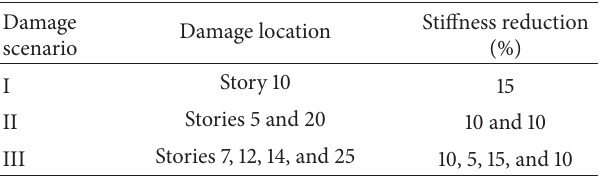
Figure 17: Convergence history of the ICA for the 25-story shear frame for scenario III. Table 6: The considered damage scenarios in the 25-story shear